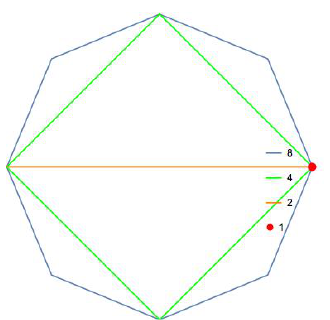
Figure 3 . N = 8 K -gon solutions with K = 8 ; 4 ; 2 ; 1. The vertices represent clusters of N=K eigenvalues in the complex plane e 2 (cid:25) i u